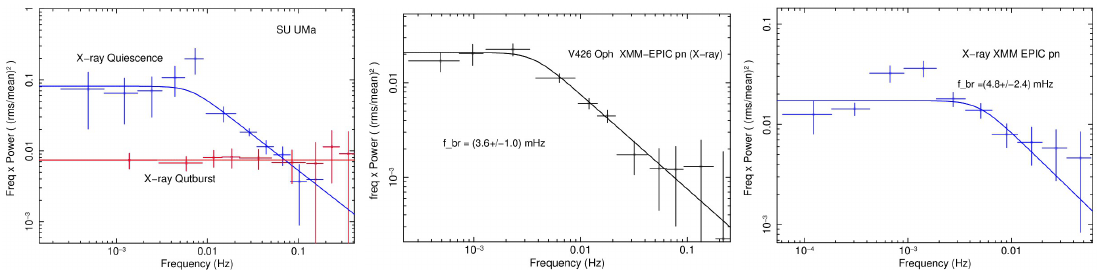
Figure 4: The RXTE PDS of SU UMa in quiescence and in optical outburst is displayed (top panel). XMM - Newton EPIC pn PDS of V426 Oph and HT Cas in quiescence (middle and bottom panel). The solid lines are the fits with the propagating fluctuations